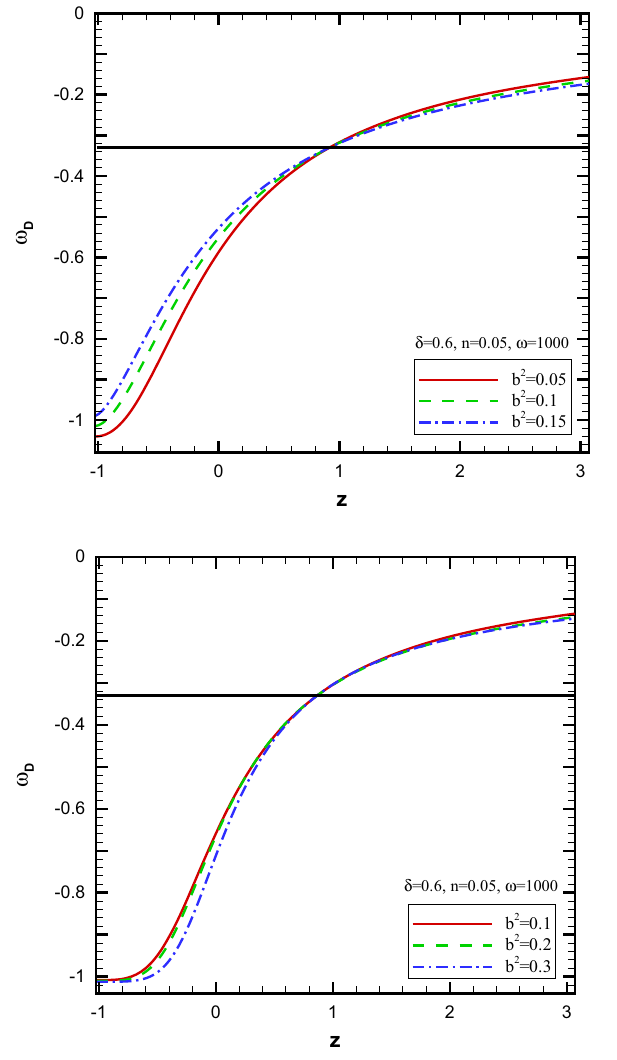
Fig. 6 The evolution of ω D and q versus z for the interacting THDE in the non-flat BD cosmology. Here, we used (cid:3) k 0 = 0 . 1 , b 2 = 0 . 1, n = 0 . 05 and ω = 1000 as the initial